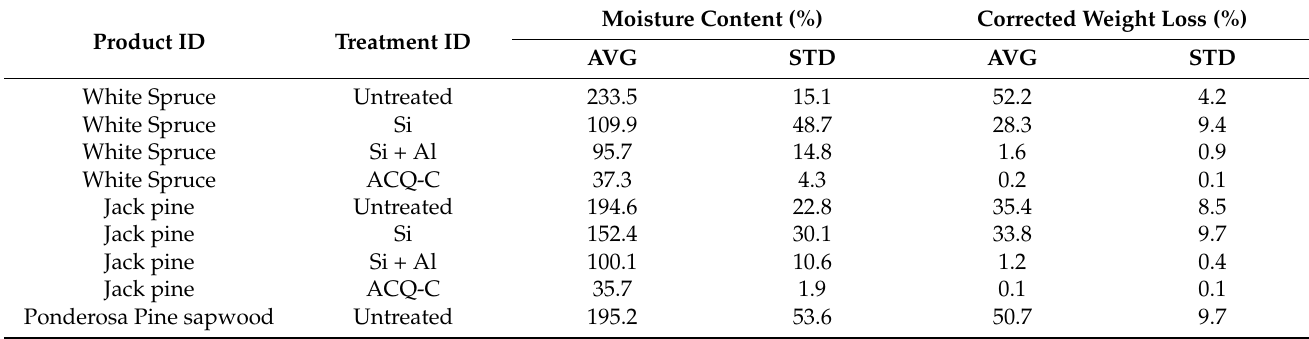
Table 9. Average values and standard deviations for moisture contents and corrected weight losses for test blocks exposed to Fibroporia radiculosa after 12 weeks of